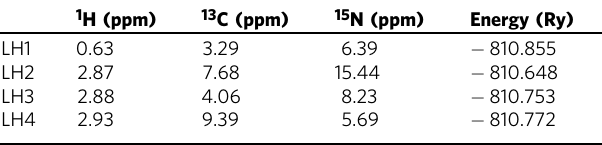
a The RMSD values were obtained between the SSNMR experimental and GIPAW-calculated isotropic chemical shifts. All the chemical shifts are listed in Supplementary Table